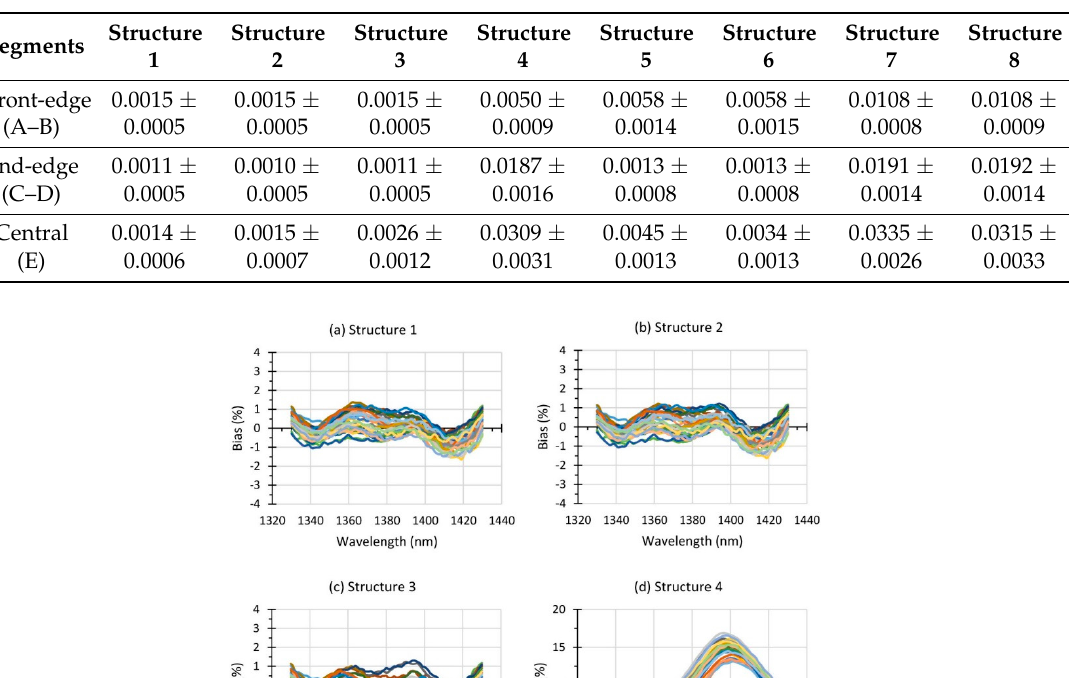
Table 3. Comparisons of the performance (mean ± standard deviation of the root mean square error (RMSE)) of the GLGCM technique with a variety of parameter sources using the laboratory based data.